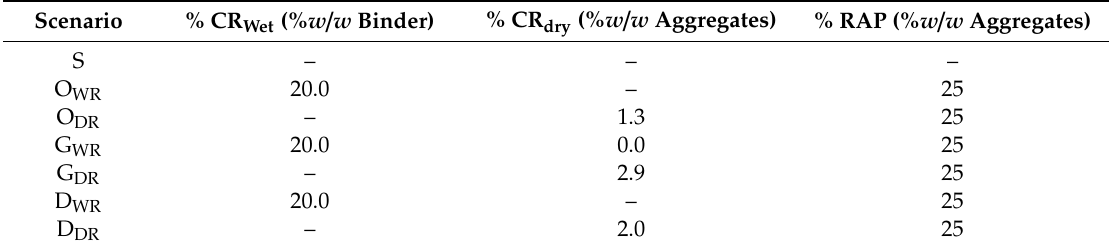
Table 2. Percentages of crumb rubber (CR) and reclaimed asphalt pavement (RAP).